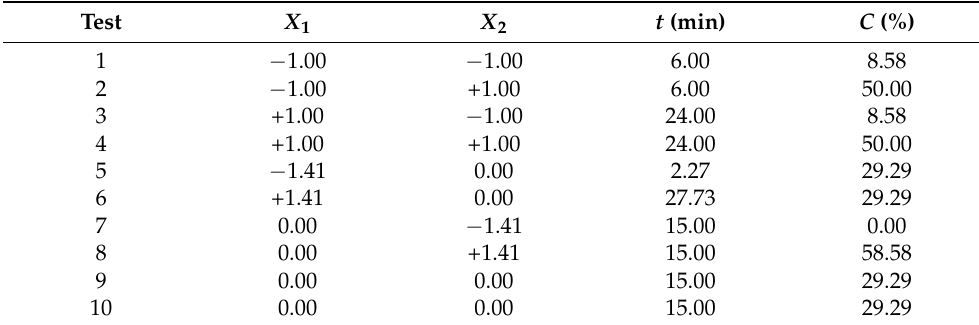
Table 1. Central composite design for solar pyrolysis